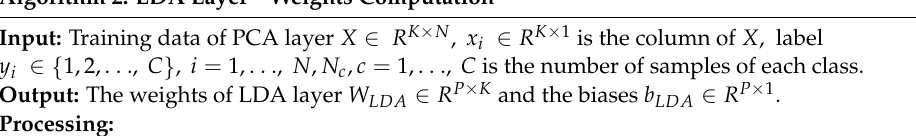
Algorithm 2: LDA Layer—Weights